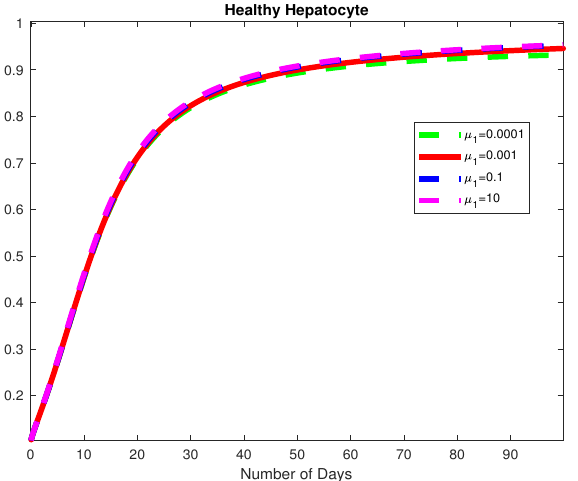
Figure 14. The dynamics of the Healthy Hepatocytes ( H ) for varying values of µ 1 .